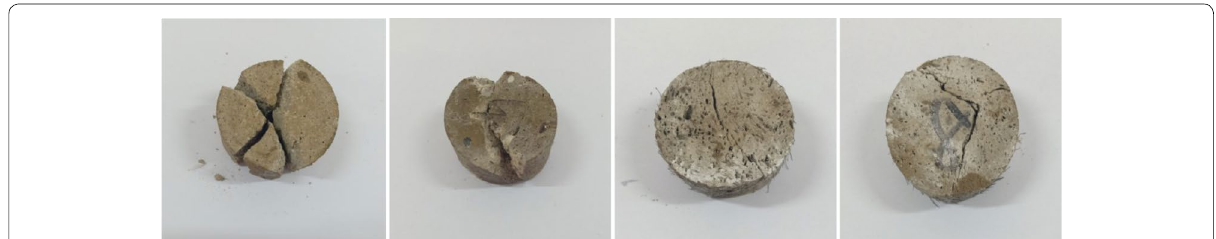
Fig. 9 Failure modes of SHCC specimens at lowest strain